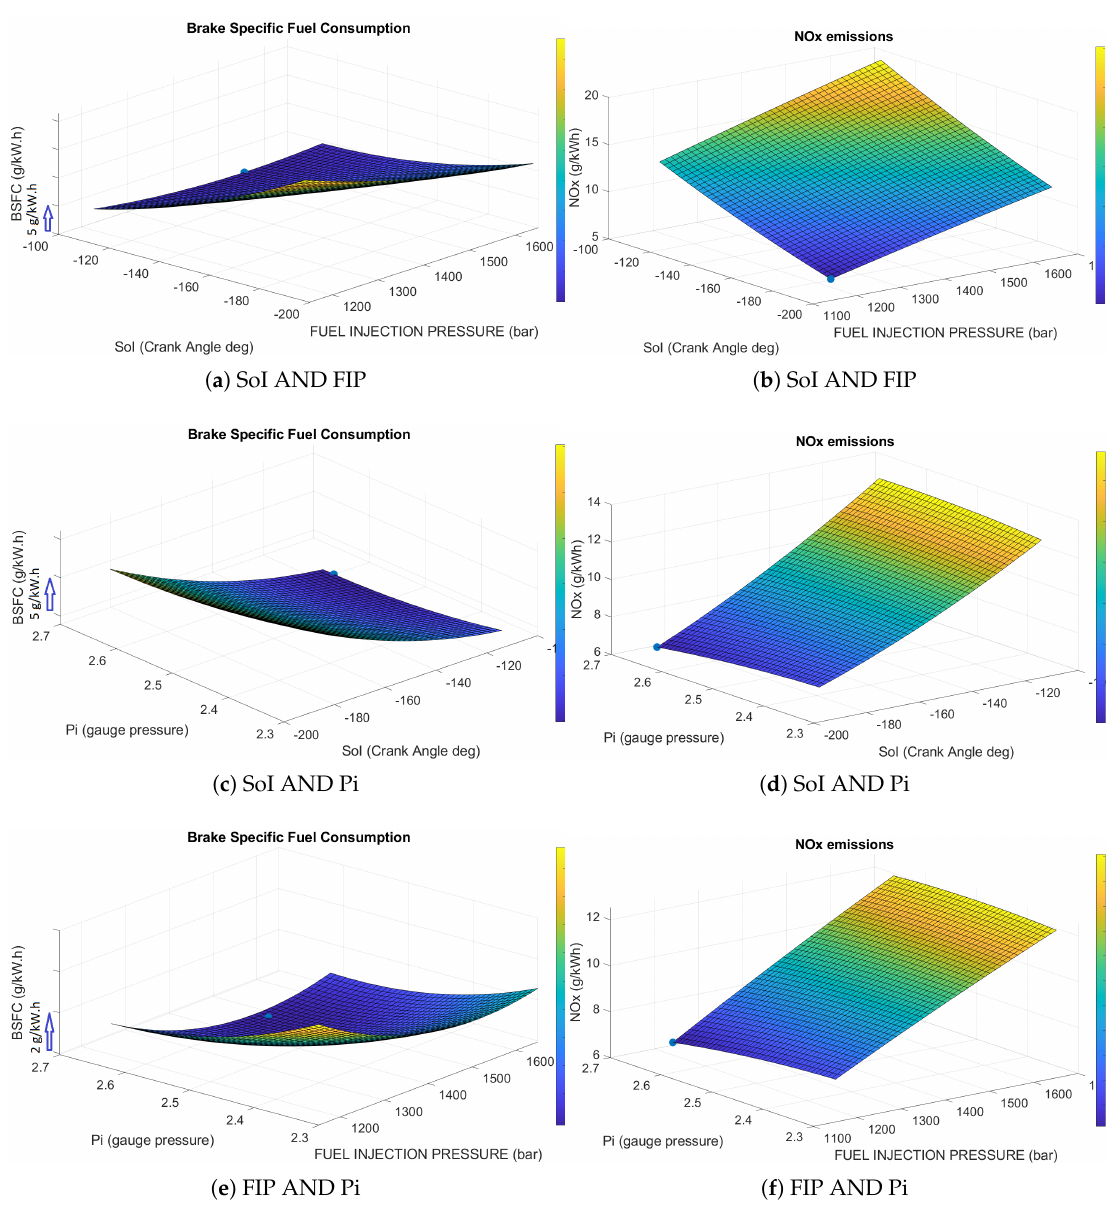
Figure A3. Response surface of the BSFC & NO x at 1000